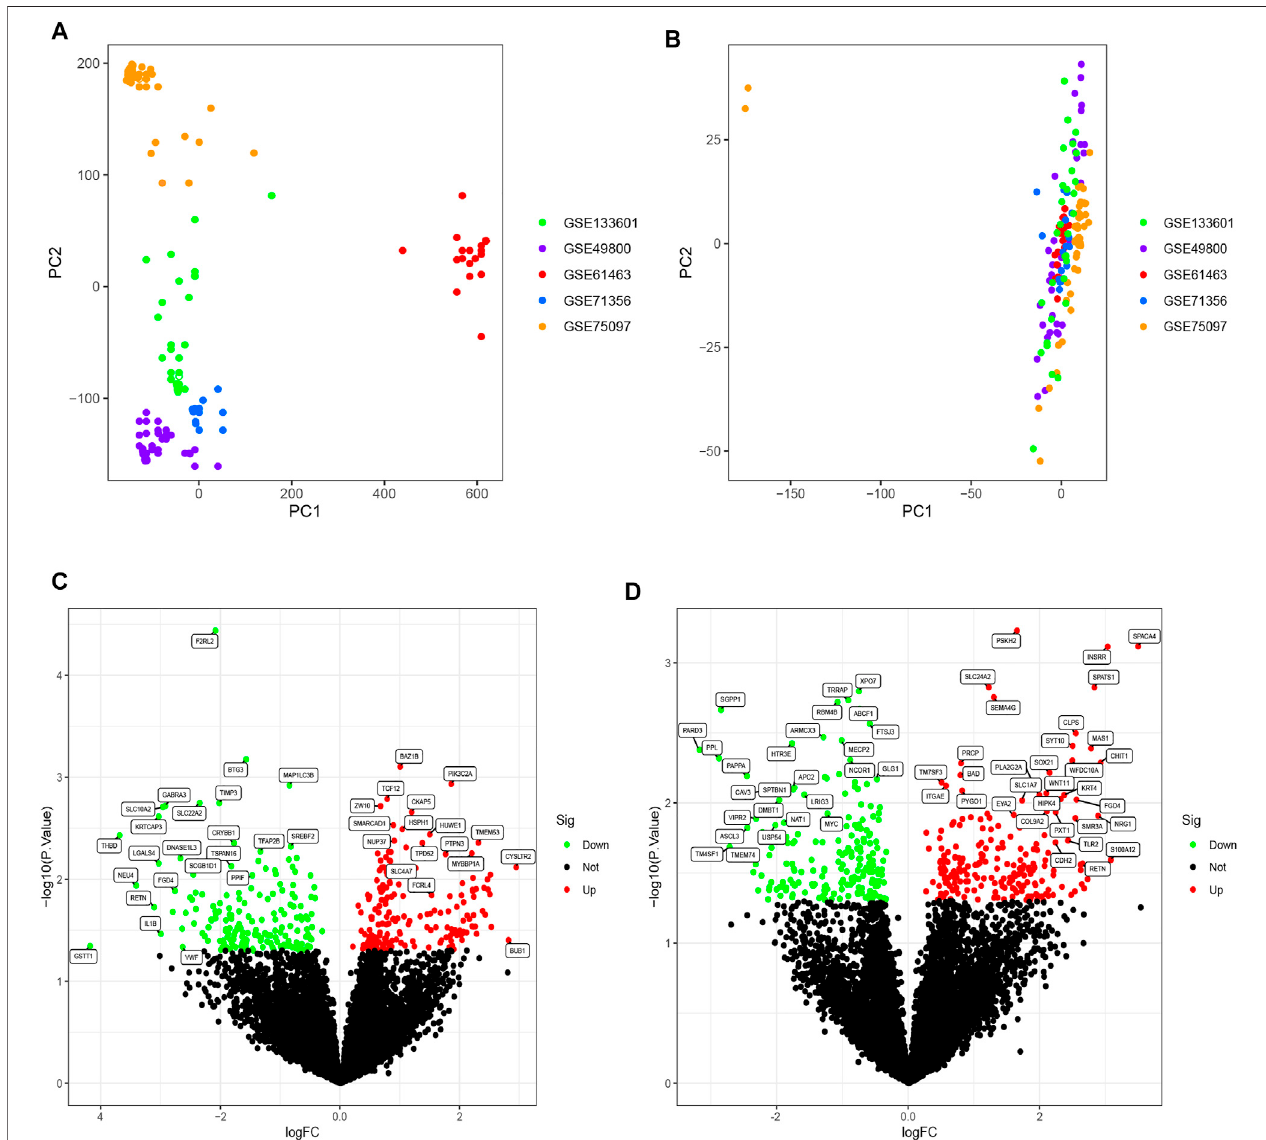
FIGURE1|(A) PCAdiagrambeforenormalization.Samplesfrom fi vedatasetsweredistributedonbothsidesofpanelAwithadistinctboundary. (B) PCAdiagram after normalization. After normalization, the data were tightly distributed. (C) Volcano plot of DEGs analysis in the OSA cohort. A logFC abscissa and (A) log10 p -value ordinate were used. Red plots in the upper right had a p value less than 0.05 and a fold change greater than 1.5, indicating up-regulated expression. Green plots on the upper left had a p value less than 0.05 and a fold change less than − 1.5, indicating down-regulated expression. (D) Volcano plot of DEGs analysis in the CPAP